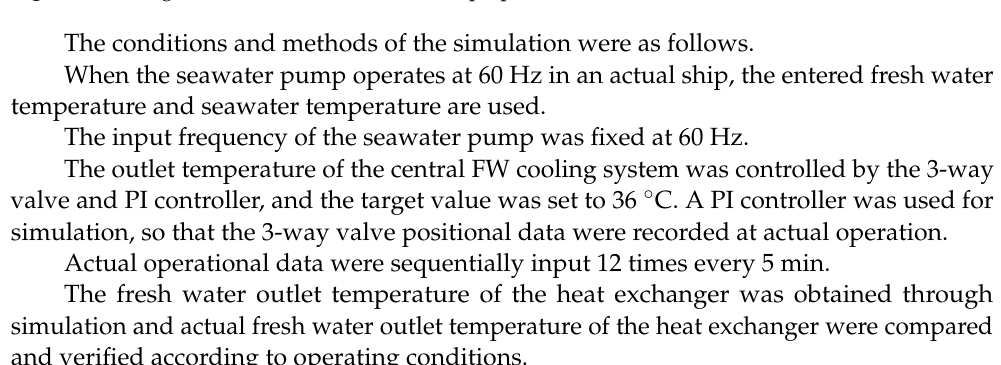
Figure 8. Configuration of simulation with ship operational data.